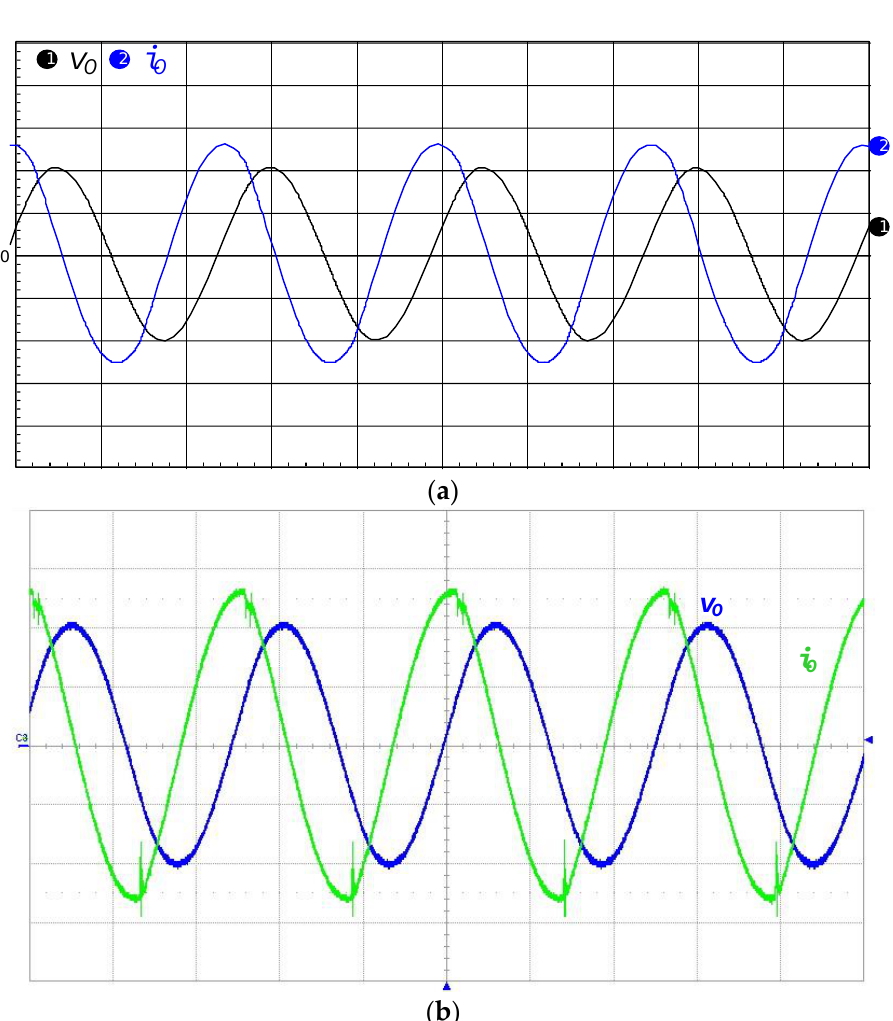
Figure 19. ( a ) Simulated and ( b ) measured output voltage v O (500 V/div) and current i O (0.5 A/div); time scale: 10 μs/div .